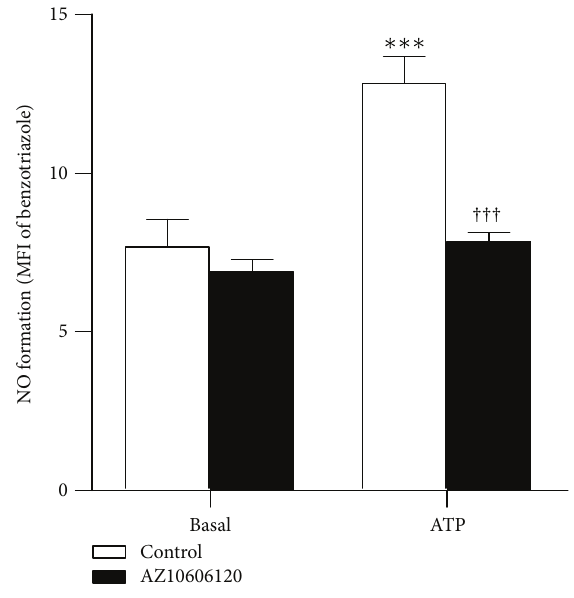
F 6: P2X7 activation induces NO formation in EOC13 microglial cells. AdherentDAF-FMDA-loaded EOC13 cellsin NaCl medium were preincubated in the absence (control) or presence C for 15min and then in the absence of 10 M AZ10606120 at 37 (basal) or presence of 1.4mM ATP for 15min. Incubations were ∘ mediumand centrifugation.Mean stopped bythe additionofMgCl 𝜇𝜇 �uorescence intensities (MFI) of ben�otria�ole (NO formation) 2 were determined by �ow cytometry and results shown as